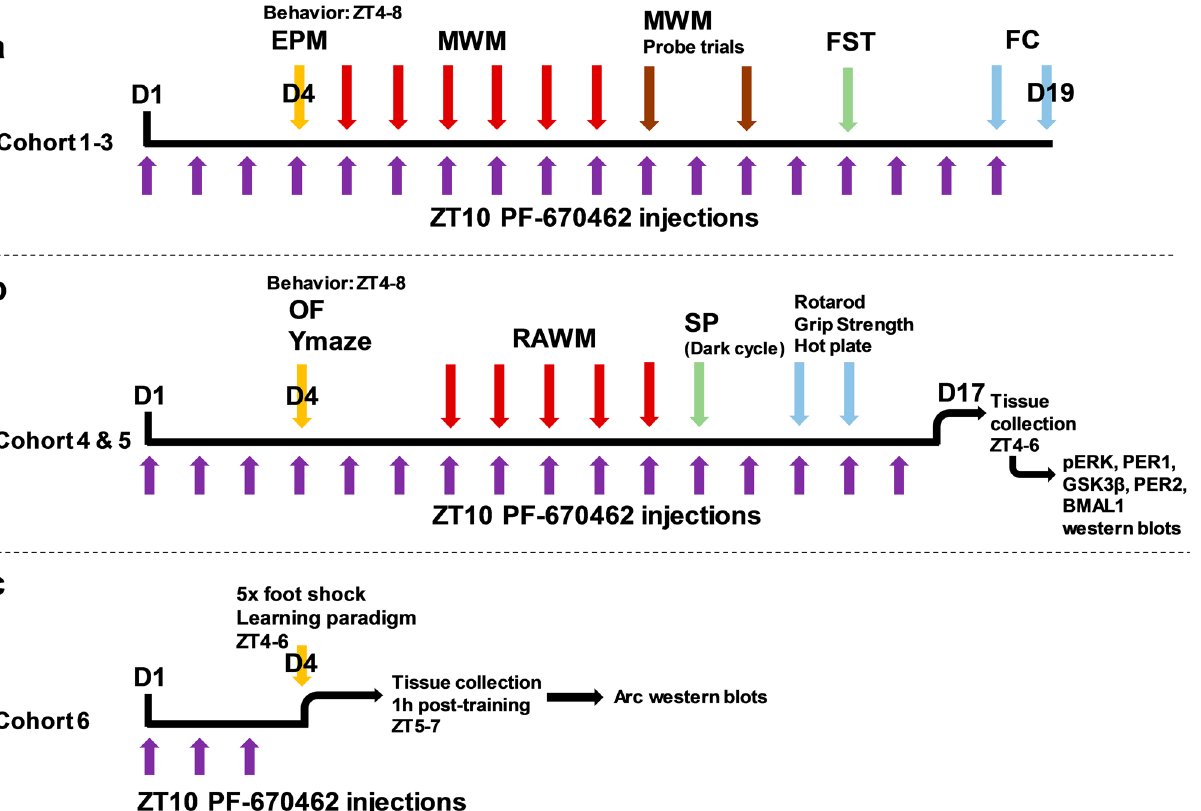
Figure 1. Experimental design. ( a ) Cohort 1–3 schedule, consisting of 18 consecutive days of ZT10 CK1i injections, and elevated plus maze (EPM), Morris water maze (MWM), Porsolt forced swim test (FST), and fear conditioning (FC). ( b ) Cohort 4 and 5 schedule, consisting of 16 consecutive days of ZT10 CK1i injections, open field (OF), Ymaze, 6-arm radial arm water maze (RAWM), sucrose preference test (SP), Rotarod, grip strength, and hot plate tests followed by tissue collection. ( c ) Arc experiment schedule, consisting of 3 days of ZT10 CK1i injections followed by a 5-shock fear conditioning learning paradigm, and tissue collection 1 h